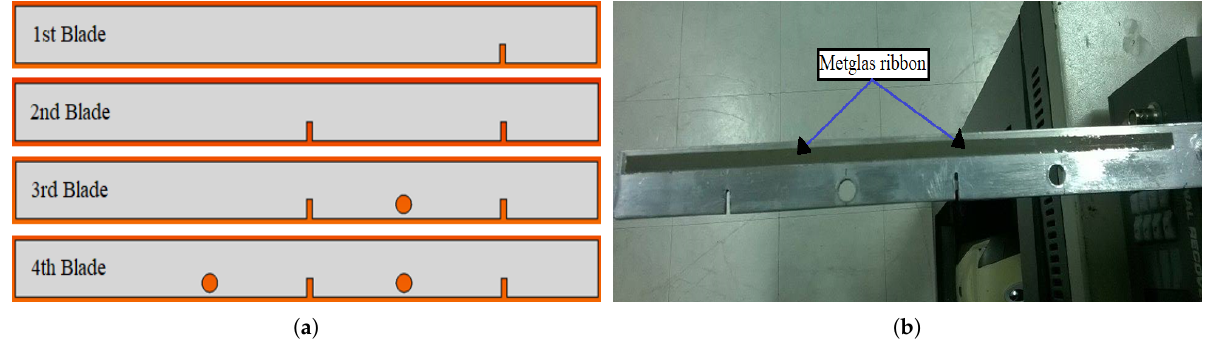
Figure 10. ( a ) Schematic illustration of the type of the damage introduced on each rotating blade. ( b ) The damaged 4th rotating blade along with the attached Metglas